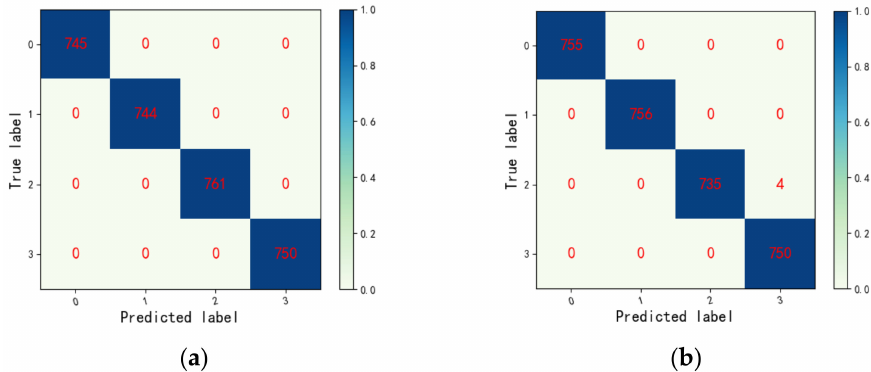
Figure 16. Confusion matrix of the 20th experiment of HSDAE model on data set H. ( a ) The confusion matrix of the HSDAE model in the training set; ( b ) the confusion matrix of the HSDAE model in the testing